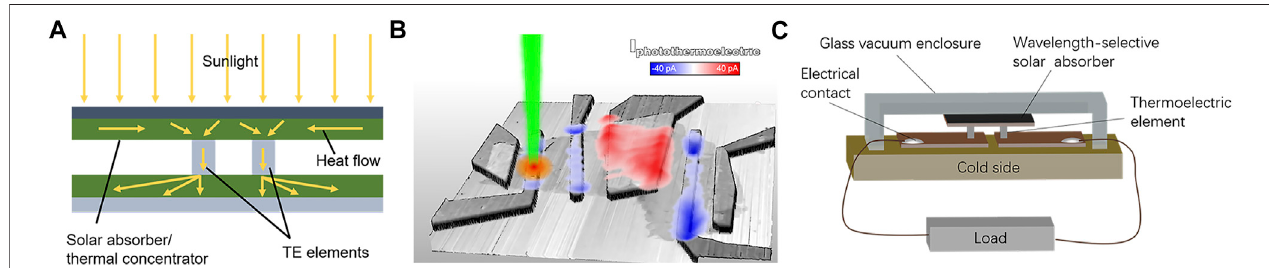
FIGURE 9 | (A) Illustration of thermal absorber and cross-section of thermoelectric elements. (B) Illustration of photocurrent generation via a giant photo- thermoelectric effect in MoS 2 and not due to optically induced electron-hole pairs. Reprinted with permission from Ref. [152], Copyright 2013, American Chemical Society. (C) Illustration of a Photo-TEG device made of a pair of p - and n -type thermoelectric elements, a fl at-panel selective absorber, and two bottom electrodes and radiation shields. The device is surrounded by a glass vacuum